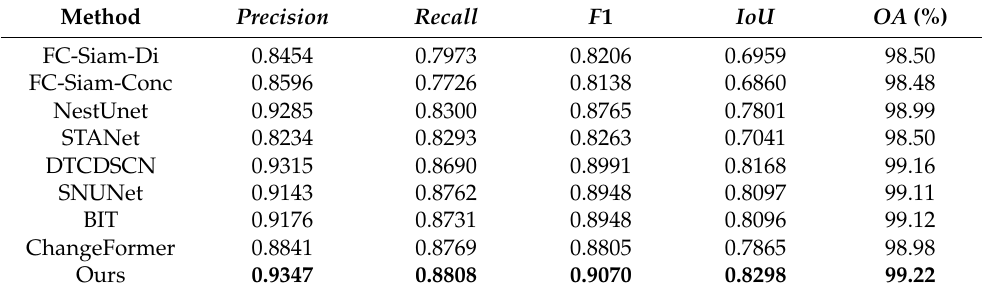
Table 2. Quantitative performance comparison on the WHU-CD dataset. (The best performance is emphasized in